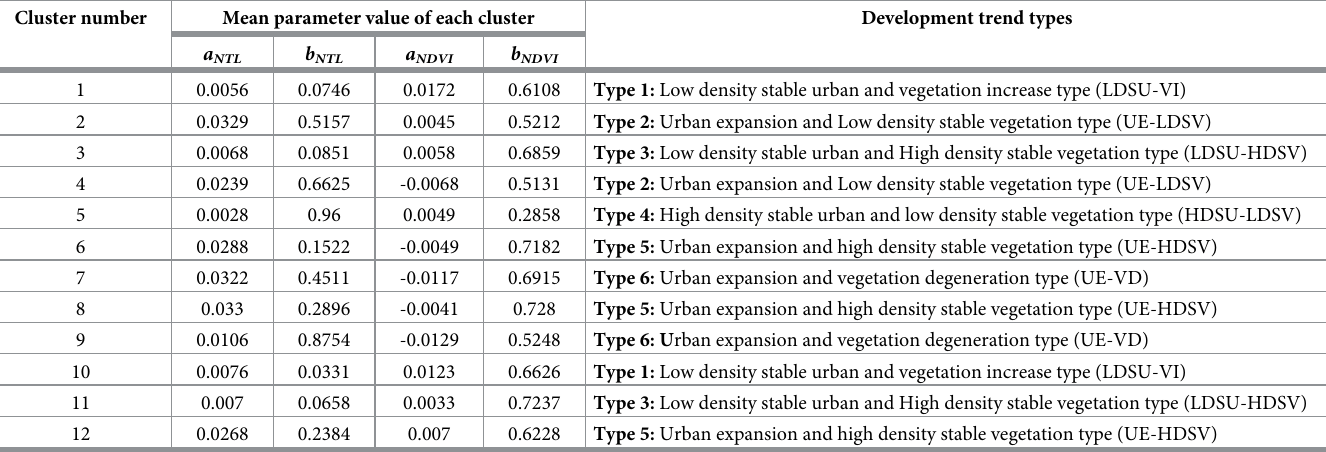
Table 1. Results of clustering the linear model parameters and the urban development trends of each cluster. Cluster